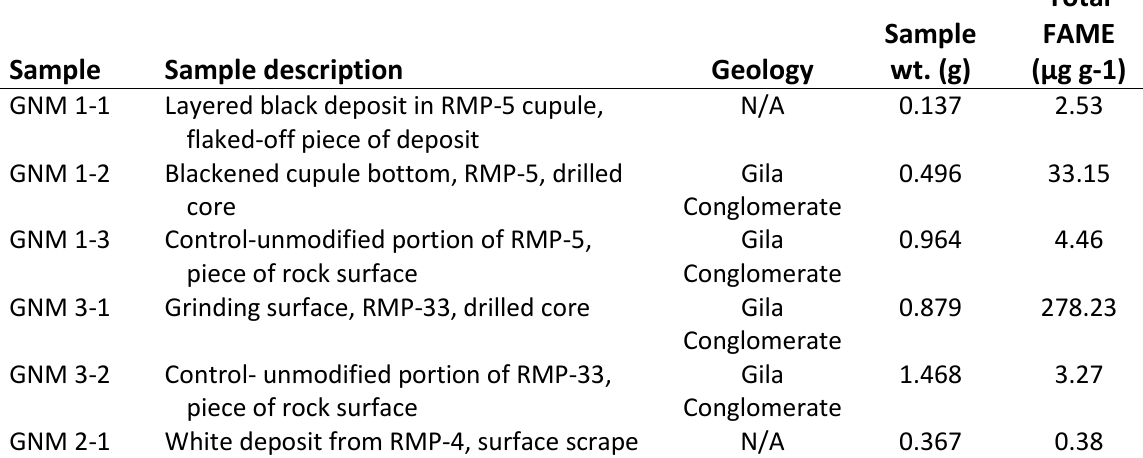
Table 1. Quantities of FAMEs in Gila Cliff Dwellings samples. Abbreviation: FAME: fatty acid methyl